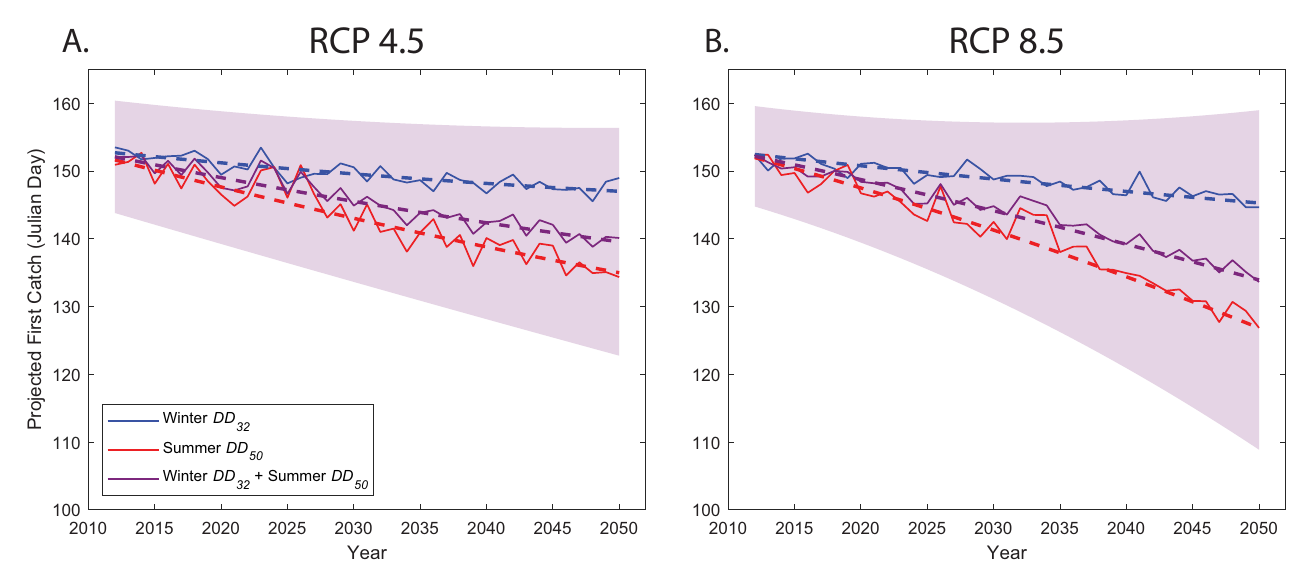
Fig 5. Projected Drosophila suzukii capture date based on three linear models corresponding to winter DD 32 (blue), prior summer DD 50 (red), and a multiple linear model incorporating both winter DD 32 and prior summer DD 50 (purple) for the following two climate change scenarios: A. RCP 4.5 and B. RCP 8.5. Dashed lines represent a quadratic fit of each model output. The purple shaded region represents a quadratic fit to the range of the 95 th percent confidence bounds of the combined winter DD 32 and prior summer DD 50 linear model. All data shown are model outputs driven by climate model output and may not match observed capture